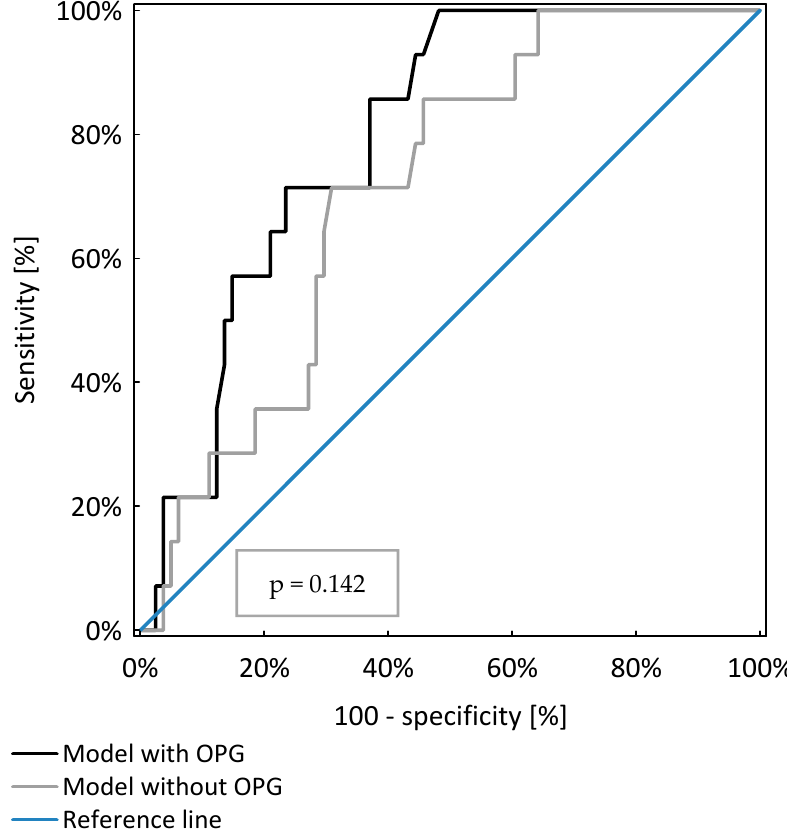
Figure 2. Comparison of two models of logistic regression analysis identifying CKD patients with protein energy wasting.